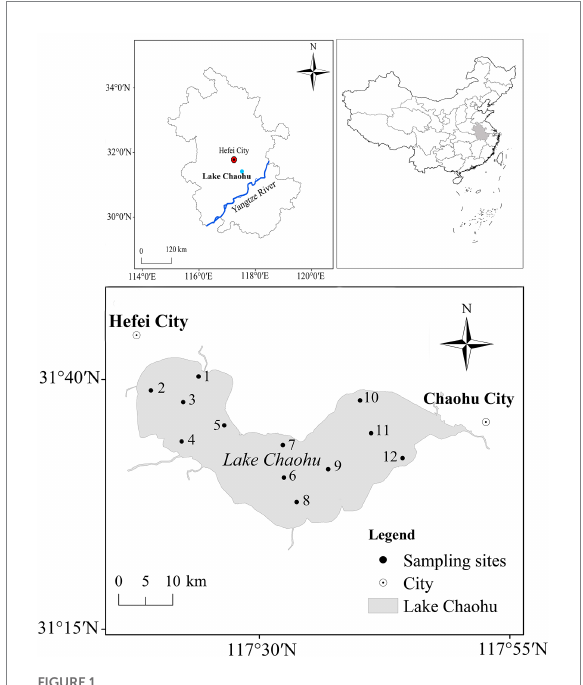
FIGURE 1 Distribution of sampling sites in Lake